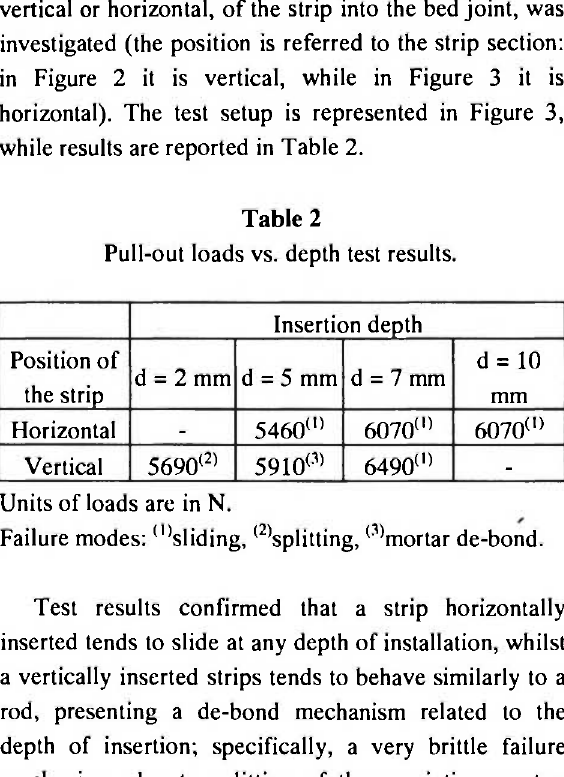
Fig. 3: Test specimen and setup scheme of the Pull-out vs. depth test.